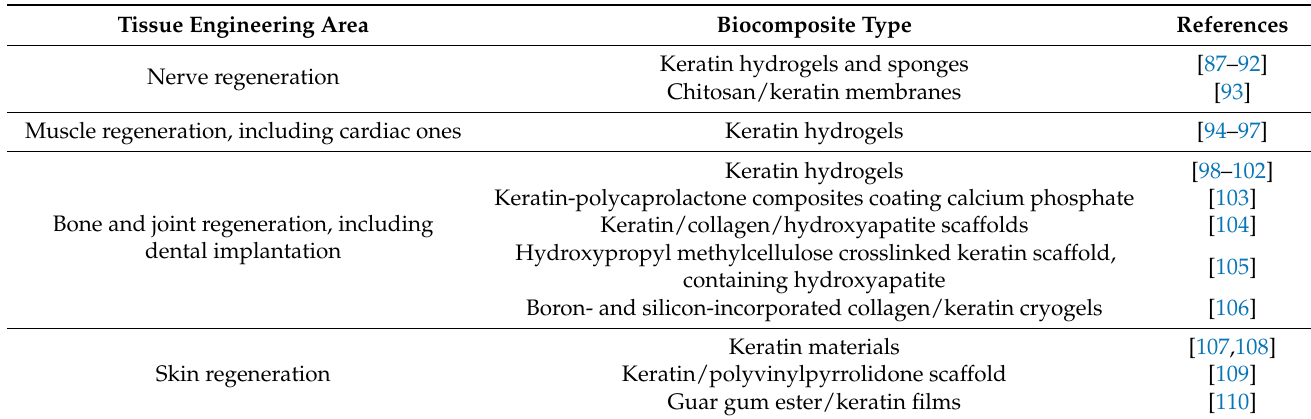
Table 2. Application areas of keratin biomaterials in tissue